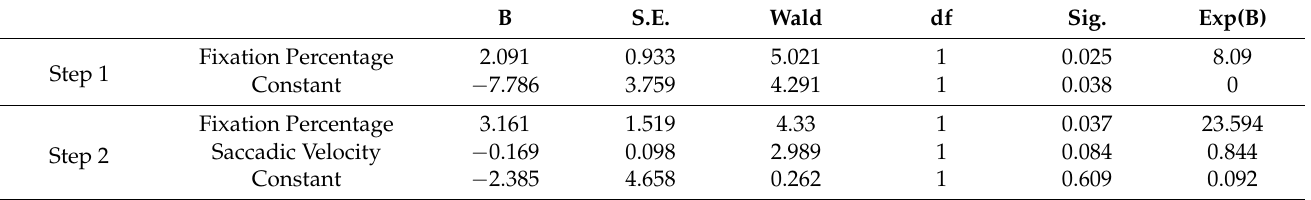
Table 4. Estimated results for model